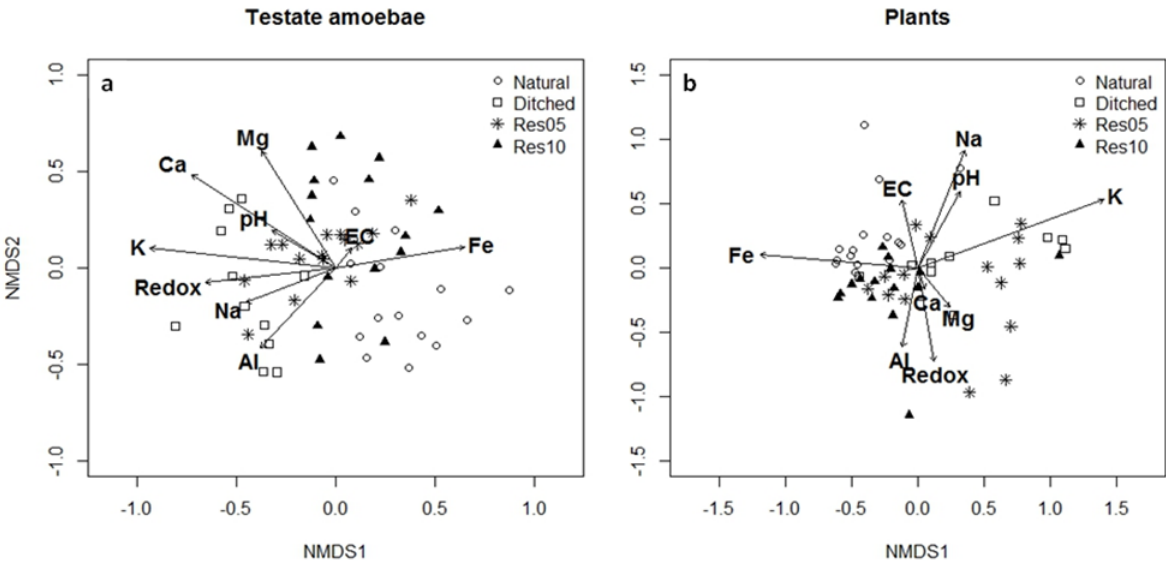
Figure 5. NMDS ordinations of testate amoebae (a) and plant community (b) relationships among management classes. Distance measure: Sørensen (Bray-Curtis). Arrow lengths represent the vector loadings of environmental variables. Res05: peatlands restored 3–7 years ago; Res10: peatlands restored 9–12 years